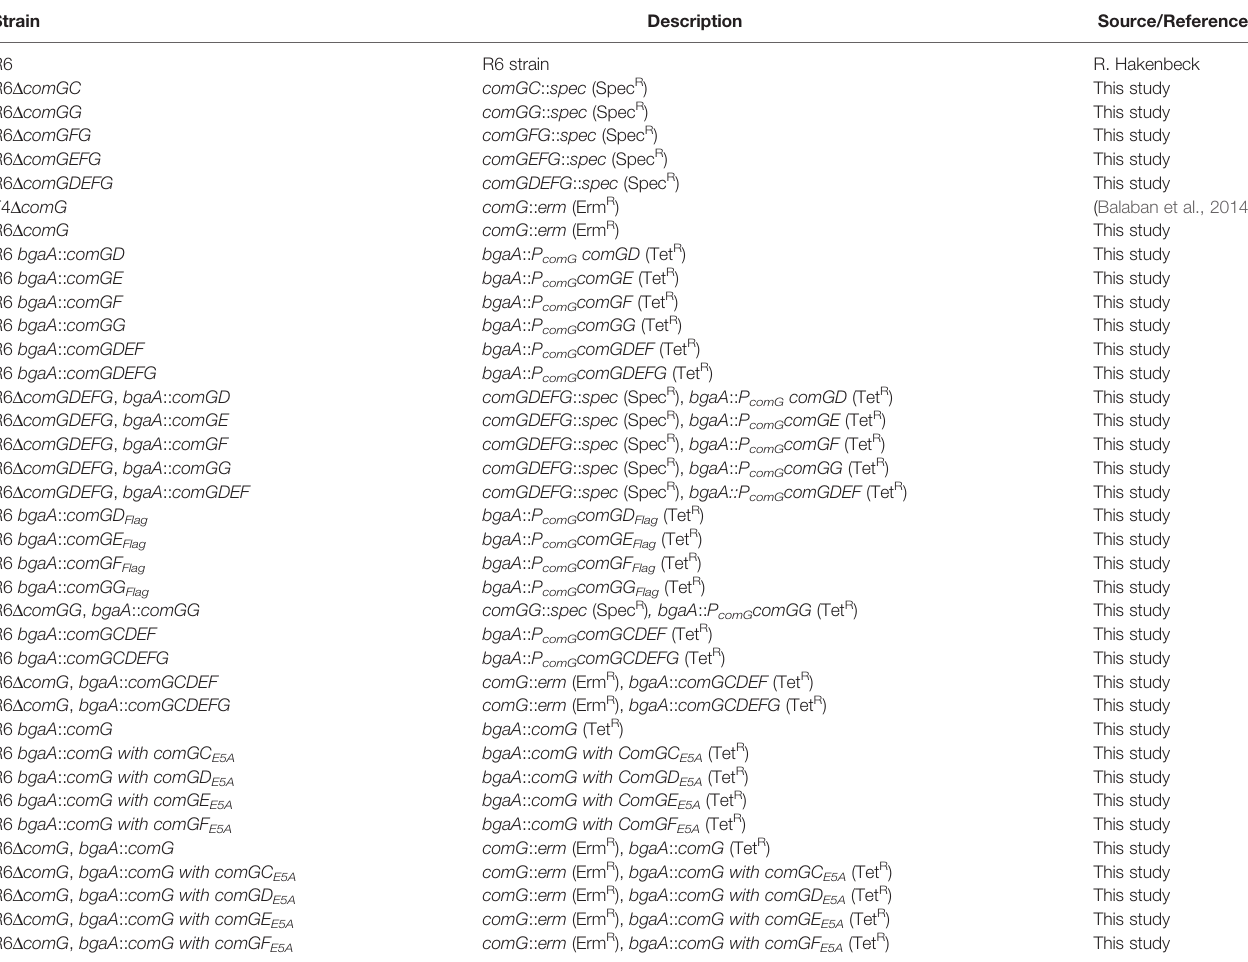
TABLE 1 | S. pneumoniae strains used in this study.